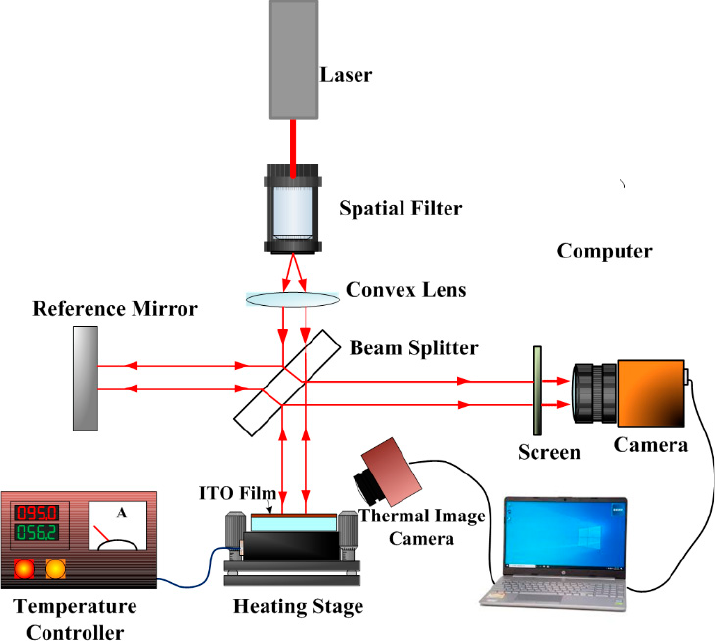
Figure 1. A home-made thin film thermal stress measurement system based on the Twyman-Green interferometer.